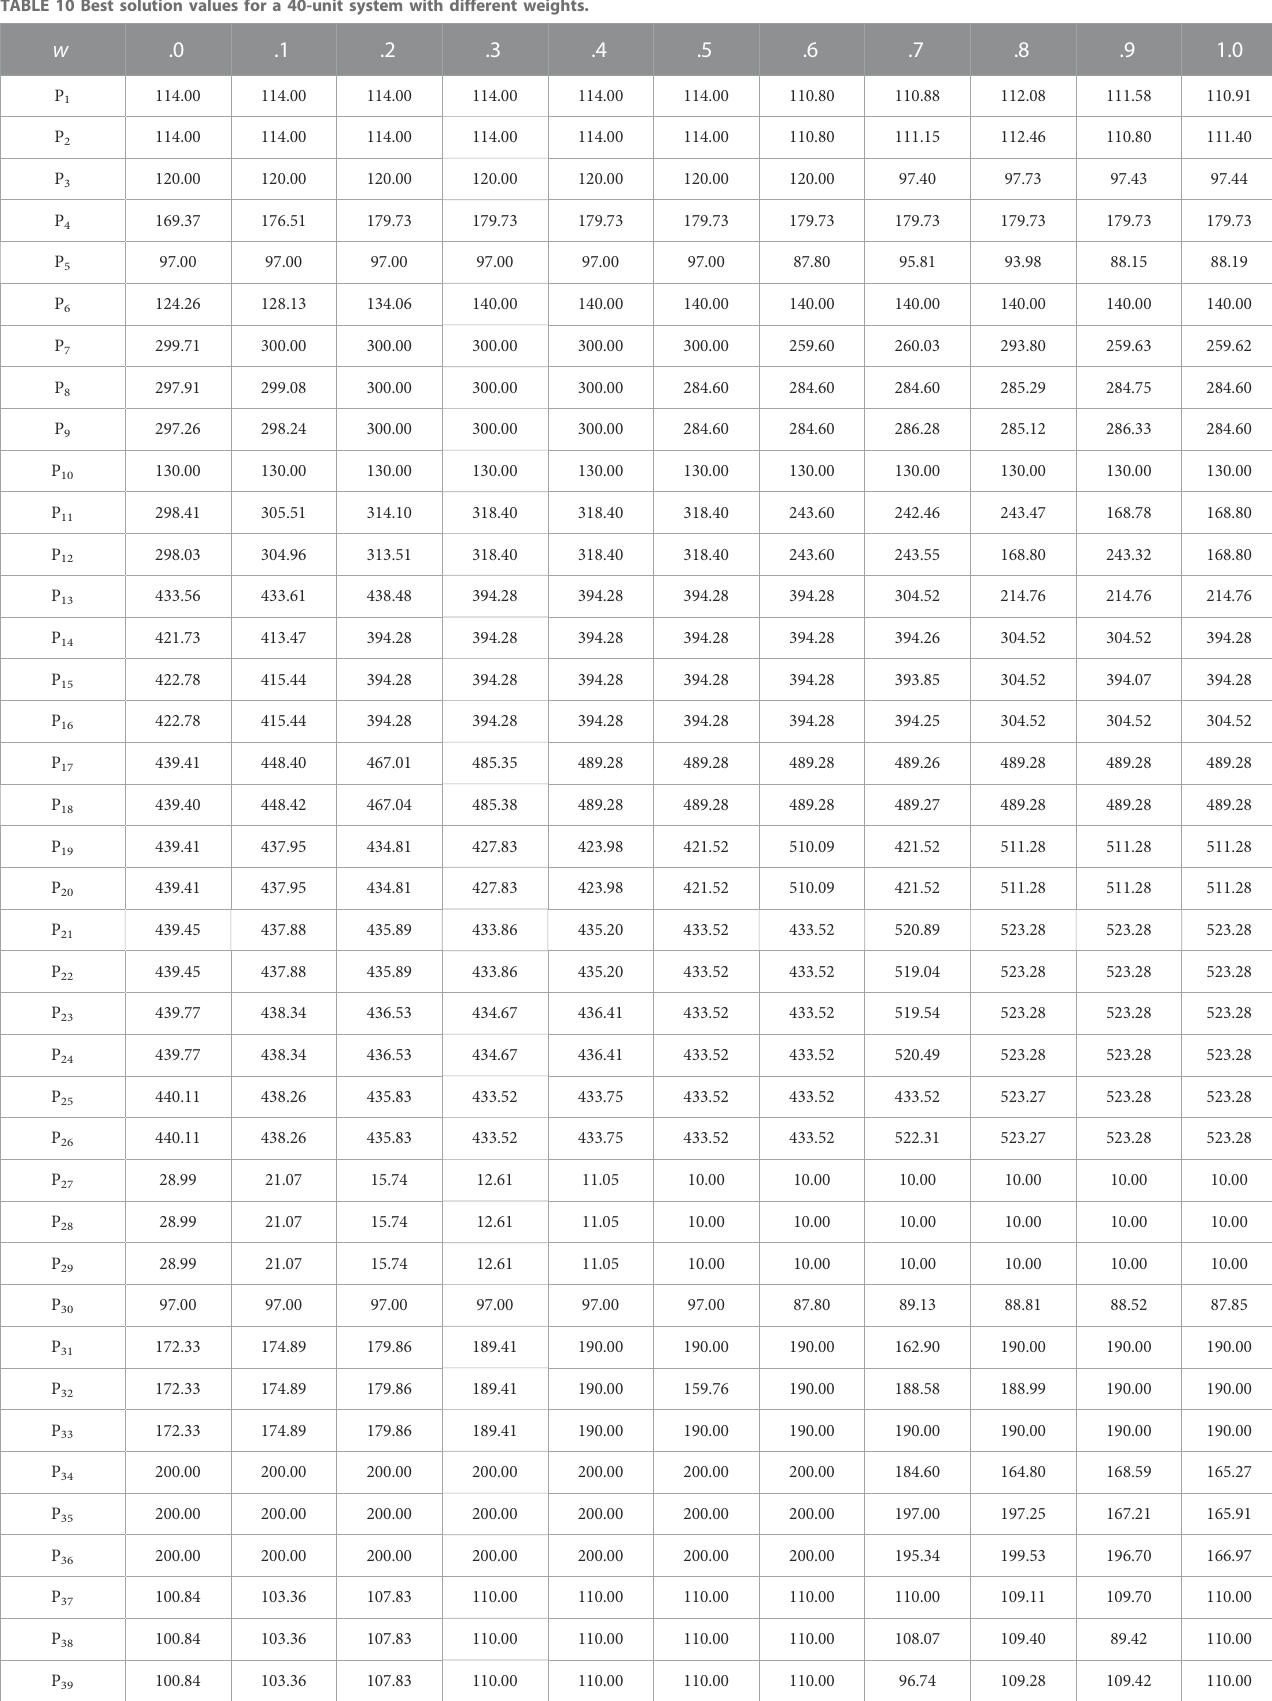
TABLE 10 Best solution values for a 40-unit system with different weights. w .0 .1 .2 .3 .4 .5 .6 .7 .8 .9 1.0